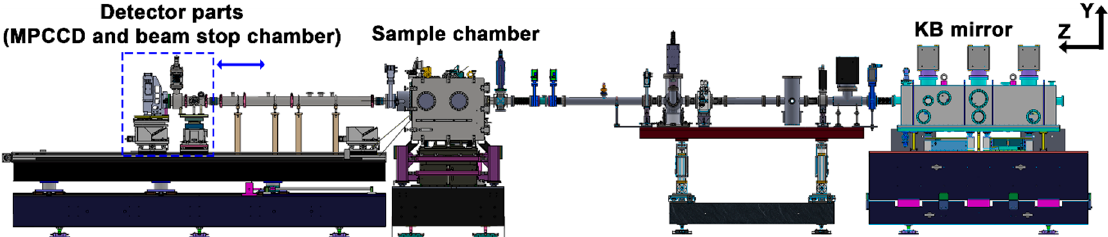
Figure 1. Single-shot coherent X-ray imaging instrument at NCI endstation, Pohang Accelerator Laboratory X-ray Free Electron Laser (PAL-XFEL). X-ray free electron laser (XFEL) pulses are focused by Kirkpatrick–Baez mirrors (KB mirrors) with a ~5.96 m long focal length and delivered to the sample chamber. Fresh samples are supplied using a thin membrane to each X-ray pulse in the sample chamber. Diffracted signals from samples are collected by the multiport charge-coupled device (MPCCD). To avoid damage to the sensor, the beam stopper is located just upstream of the detector and blocks the direct X-ray beam. The detector parts marked by the blue box are mounted on the rail to easily change the distance between the sample and detector (the XFEL beam propagates following the z-axis in the figure).